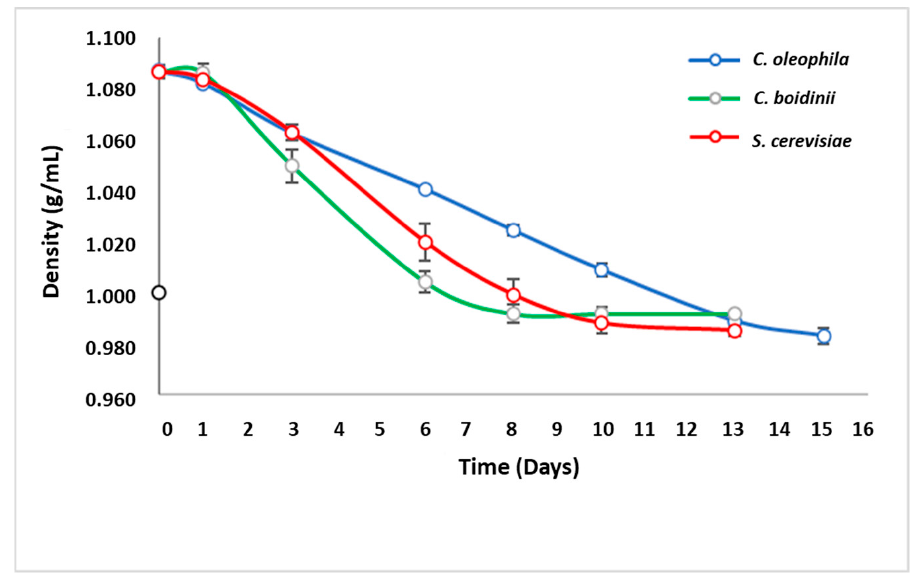
Figure 1. Evolution of substrate consumption through the measurement of density in monoculture fermentations (Sauvignon Blanc).